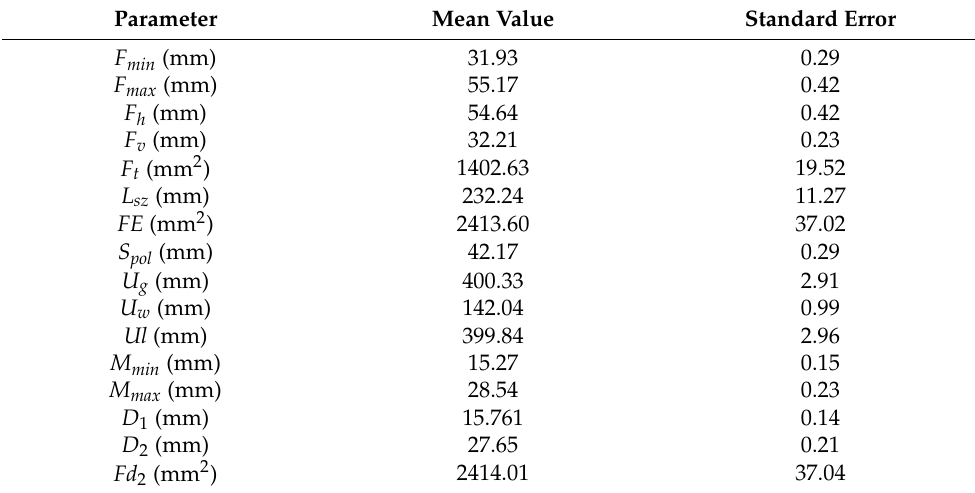
Table 2. Mean values of selected linear dimensions of ‘Mejhoul’ date fruit. Parameter Mean